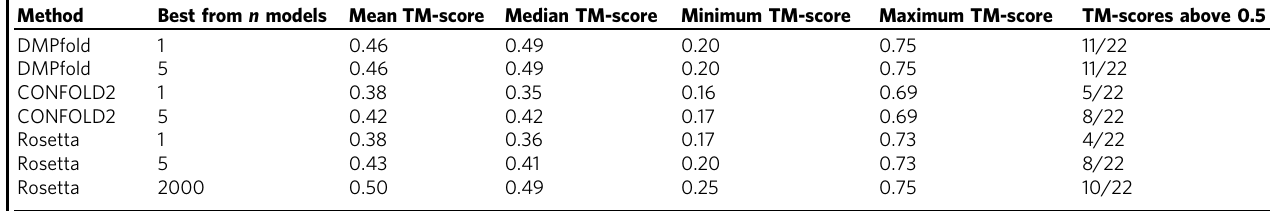
Table 1 TM-scores of models generated by each method on CASP12 FM domains